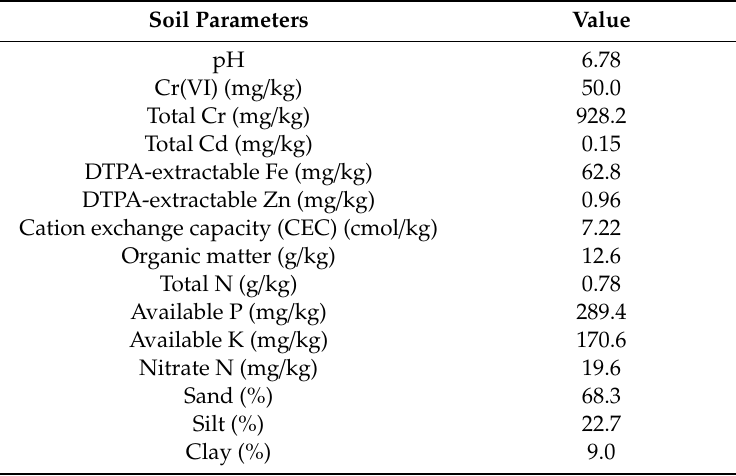
Table 1. Physicochemical properties of the soil used for pot